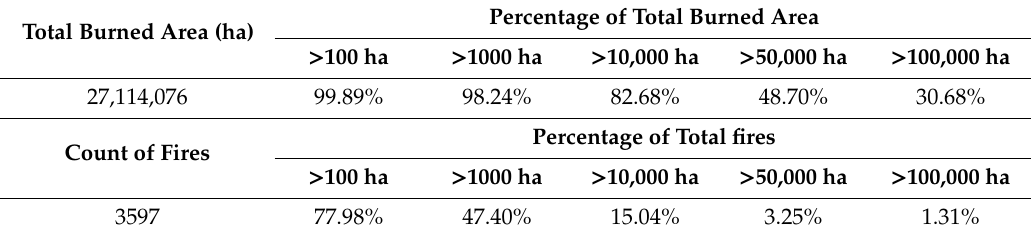
Table 1. Burned area distribution by fire size in Alaska for 1940 to 2017, as recorded by the Alaska Fire Service (AFS).